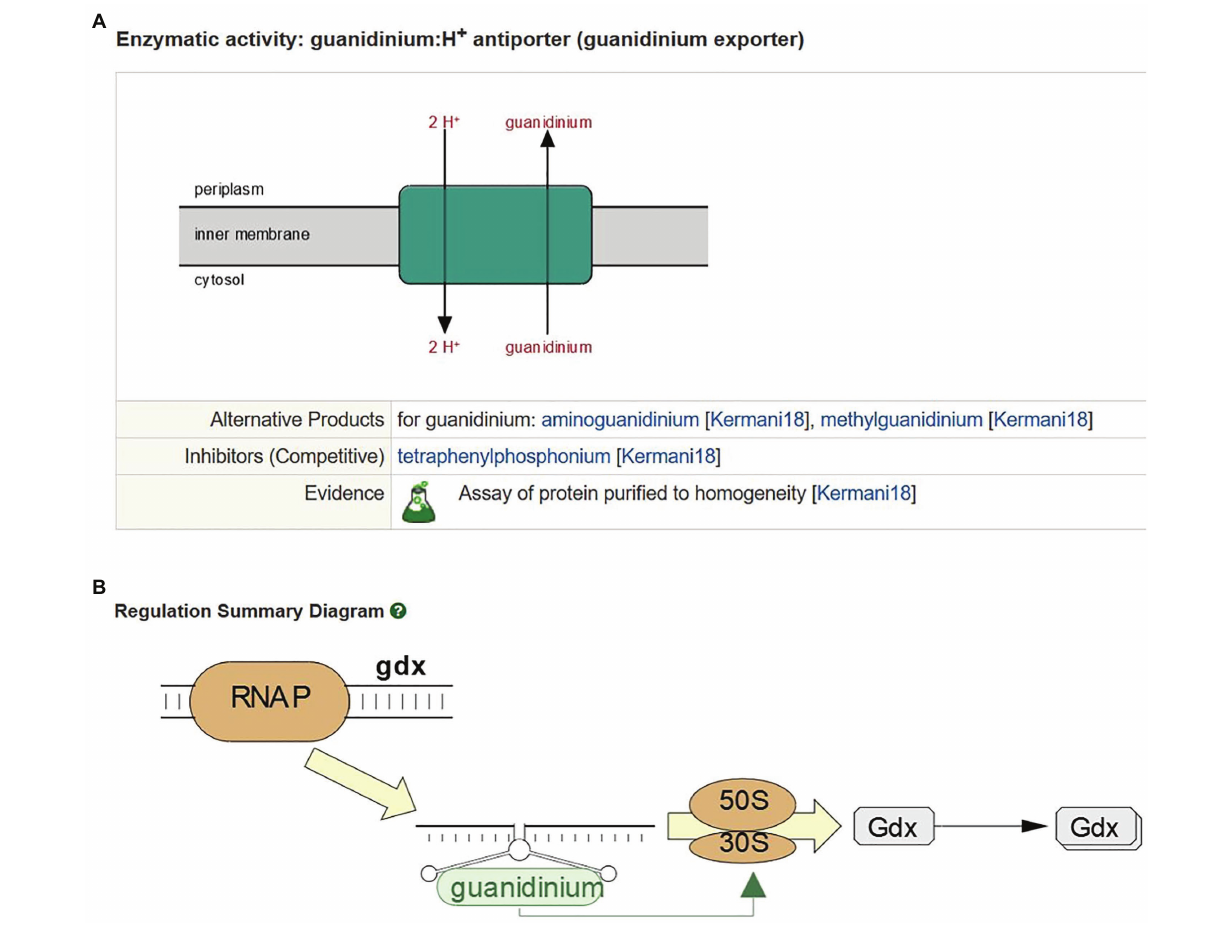
FIGURE 1 | Curation of Gdx in EcoCyc. (A) The guanidinium:proton antiport reaction mediated by Gdx. (B) Gdx regulation by a guanidine II